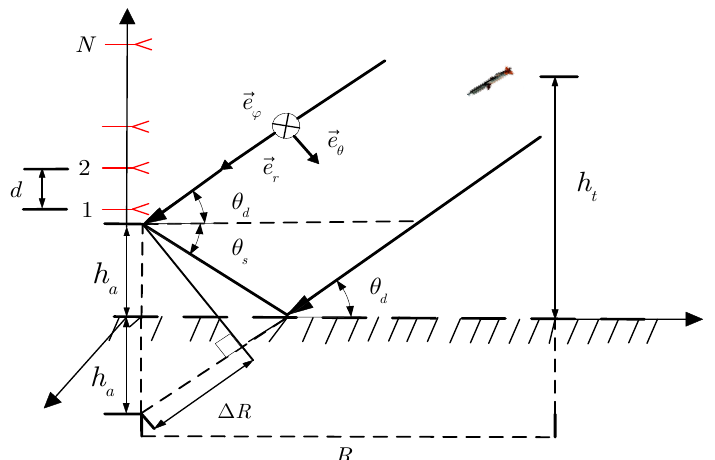
Figure 1. Multipath signal model of meter wave PSA.